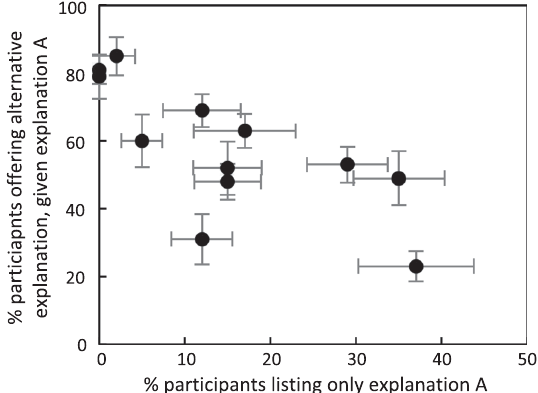
FIG. 3. Compilation of results from experiment 1, Table III (horizontal axis) and experiment 2, Table VI (vertical axis) in order to test Corollary 2. Each point represents a high or low accessibility explanation for each physical scenario. Error bars represent standard